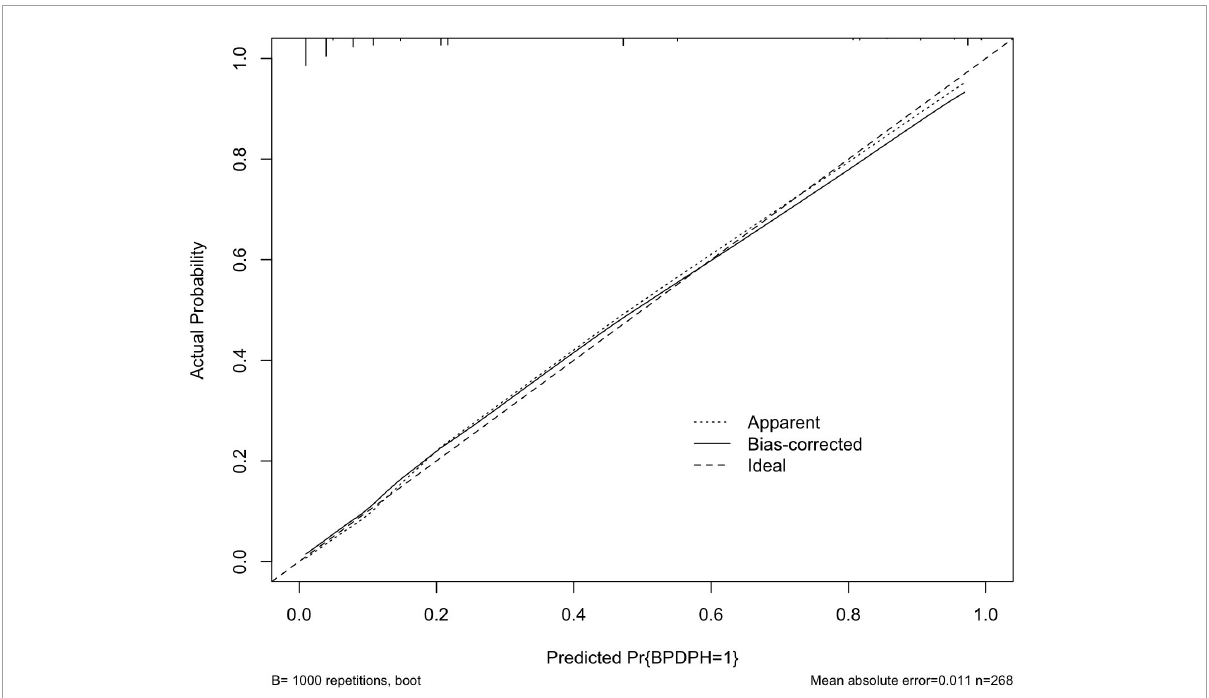
FIGURE4 A calibration curve of the prediction model. The x - and y -axes represent the predicted risk and actual outcome, respectively. The dashed line indicates perfect prediction by an ideal model. The solid line depicts the model’s